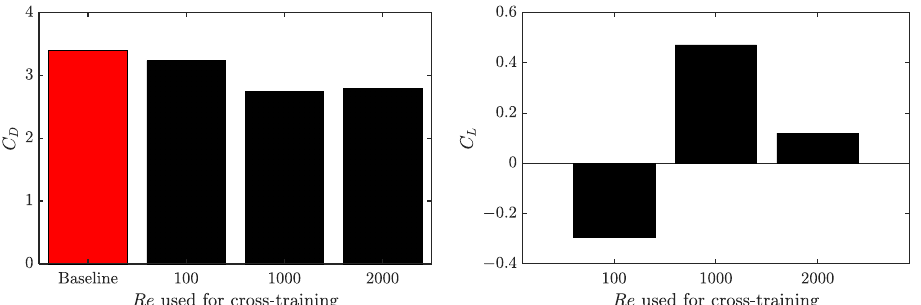
Figure 18. Average C D ( left ) and average C L ( right ) comparison between three different cross- application of agents.